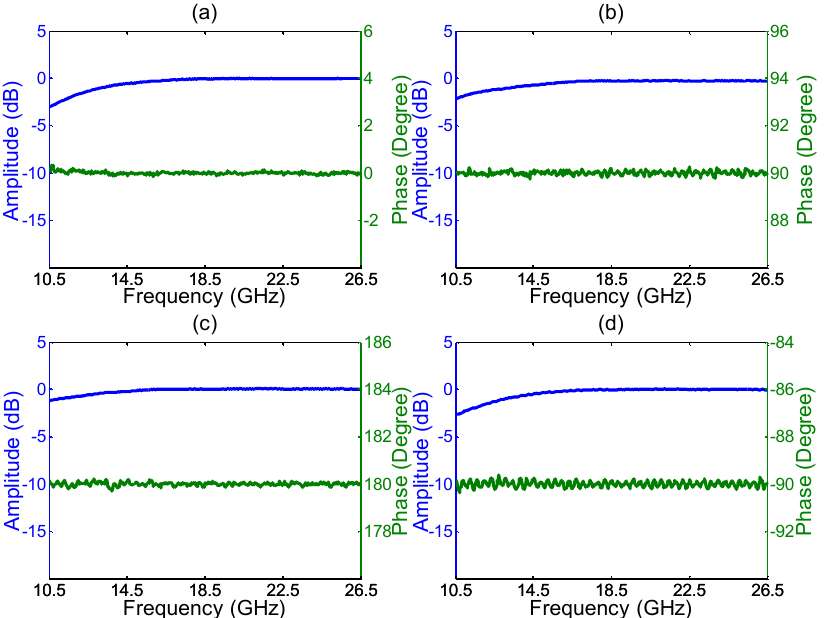
Figure 13. The measured amplitude and phase response of the 4-way RF hybrid splitter ( a ) 0°, ( b ) 90°, ( c ) 180° and ( d ) 270° ( − 90°) channel.